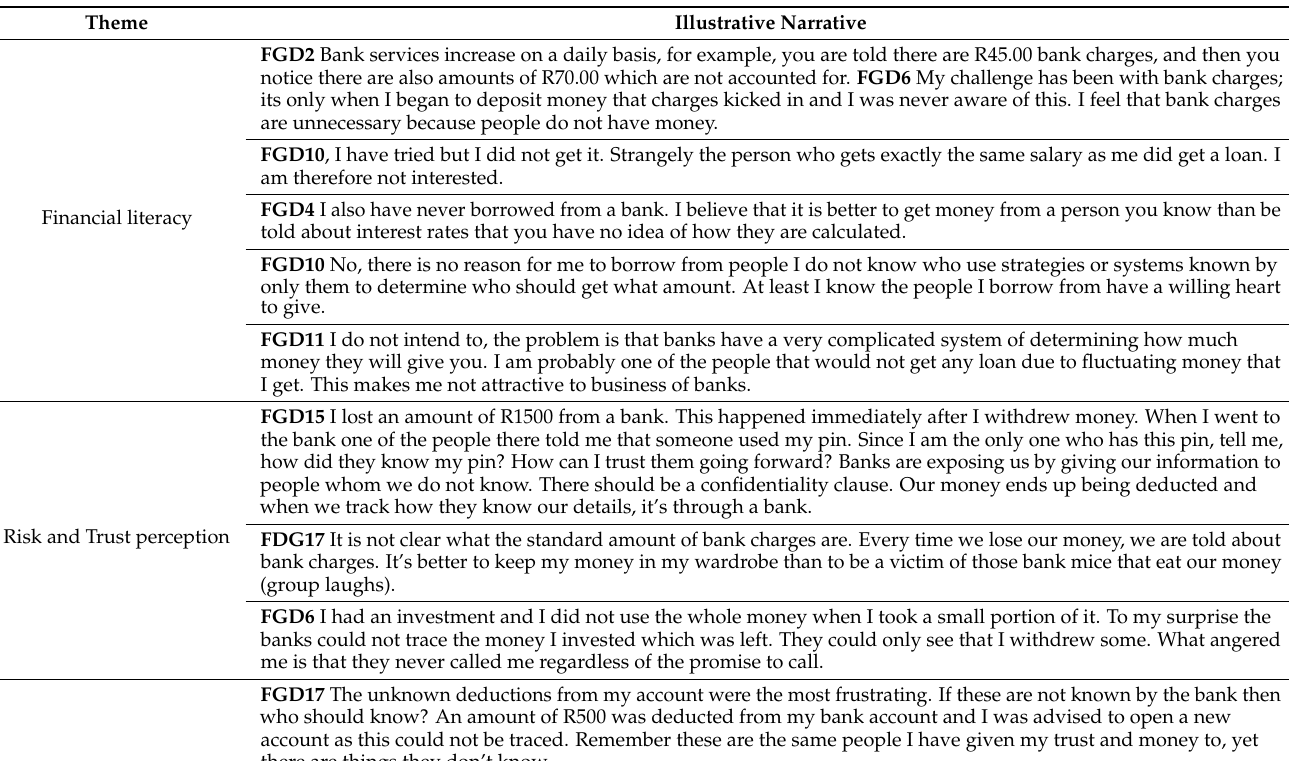
Table 6. Financial literacy and risk perception: codes and illustrative